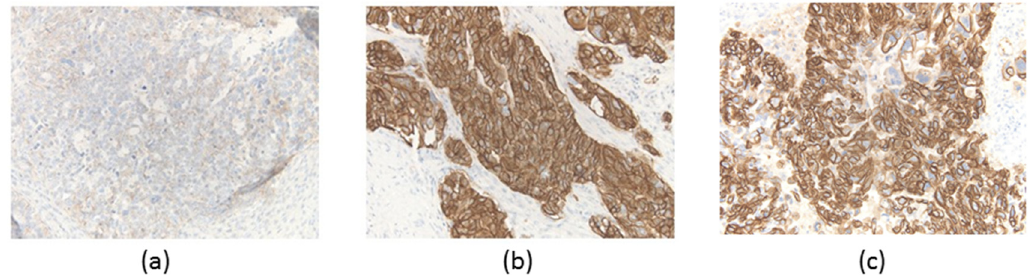
Figure 3. Immunohistochemical HER2 assessment. Region ( a ) (left panel): 1 + , region ( b ) (middle Figure 2. Immunohistochemical HER2 assessment. Region a (left panel): 1+, region b (middle panel): panel): 3 + , region ( c ) (right panel) ( × 3+, region c (right panel) (×200). Table 1. Detailed information regarding actionable gene alterations in three tumor regions.